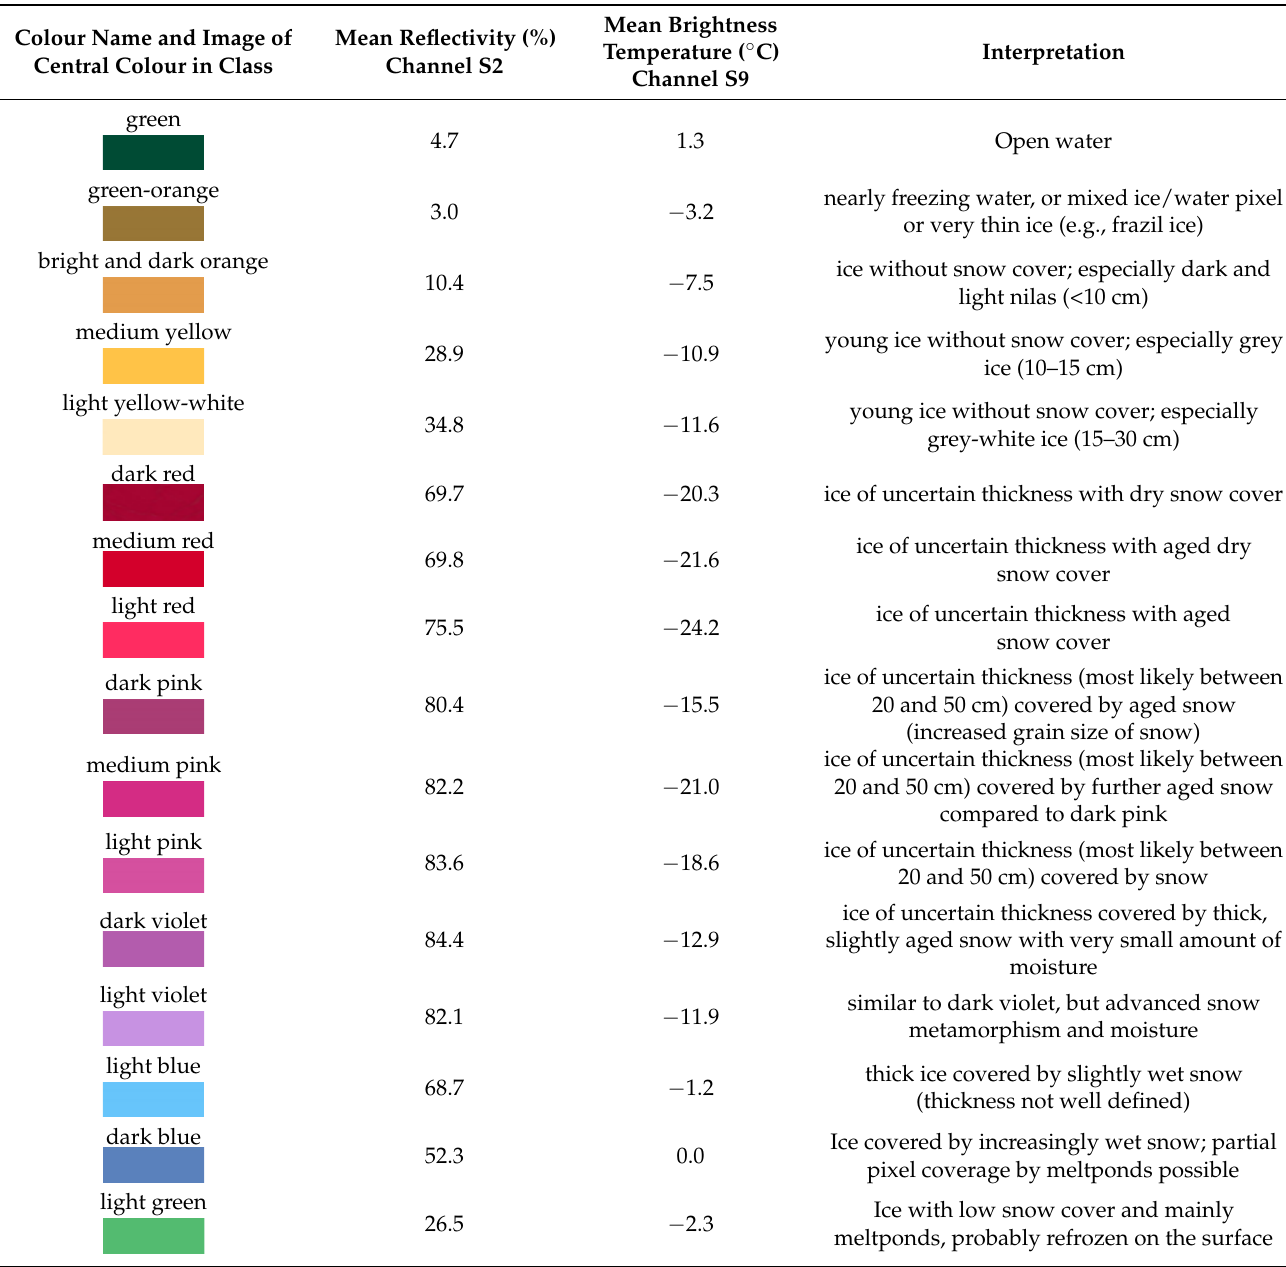
Table 2. Interpretation of main colours appearing in sea ice classification results computed from SLSTR measurements as identified by visual inspection. Mean values of top of atmosphere reflectance in channel S2 and blackbody temperature equivalent to radiation measurements in channel S9 are included for each class as derived from manually selected pixels in various scenes and seasons.